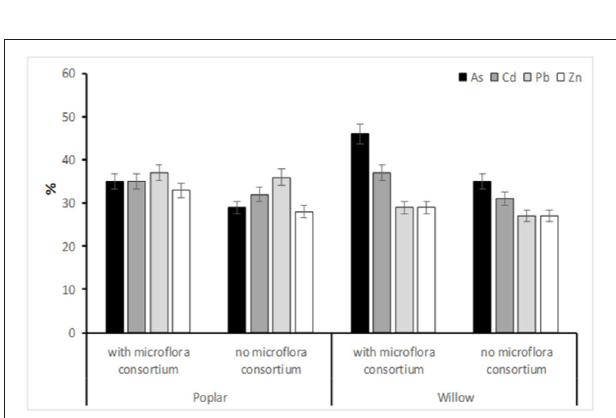
FIGURE 3 | The removal rate of in soil HMs (As,Cd, Pb, and Zn) (%) afeter 36 months (T f ). Values represent mean ±